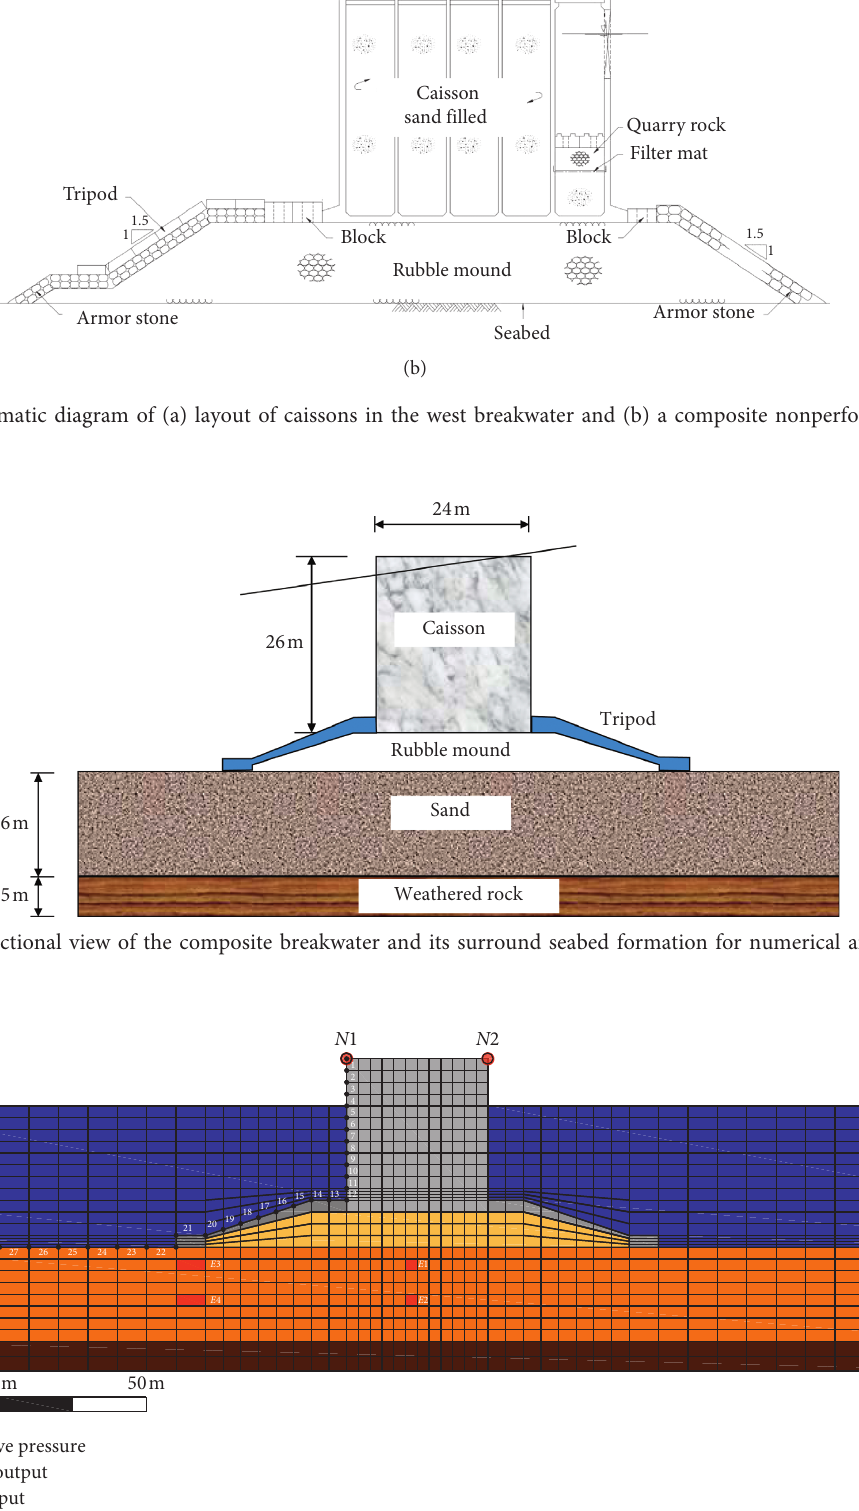
Figure 12: Modeled meshes of the composite breakwater and the